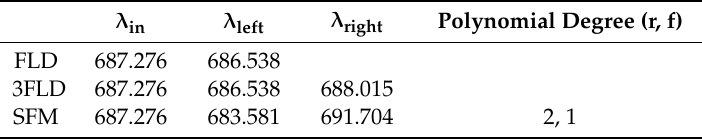
Table 5. The settings for each parameter in the O 2 -A absorption band. λ λ in λ right Polynomial Degree (r, f) left FLD 760.519 1, 1 Table 6. The settings for each parameter in the O 2 -B absorption band. λ λ in λ right Polynomial Degree (r, f) left FLD